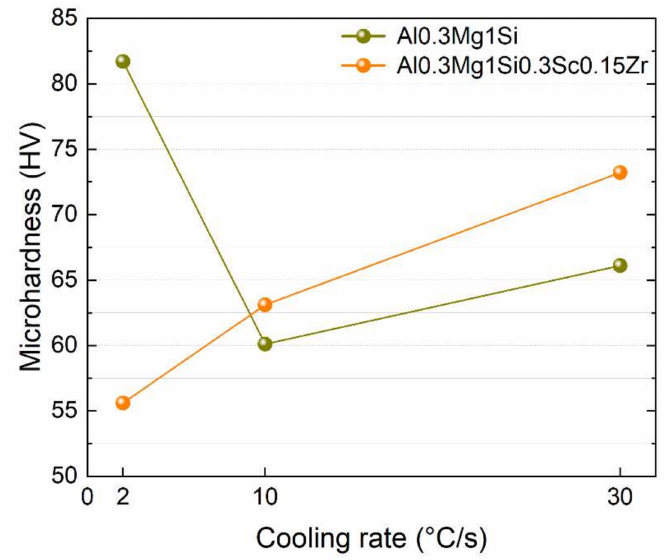
Figure 5. Microhardness of alloys depending on the cooling rate.